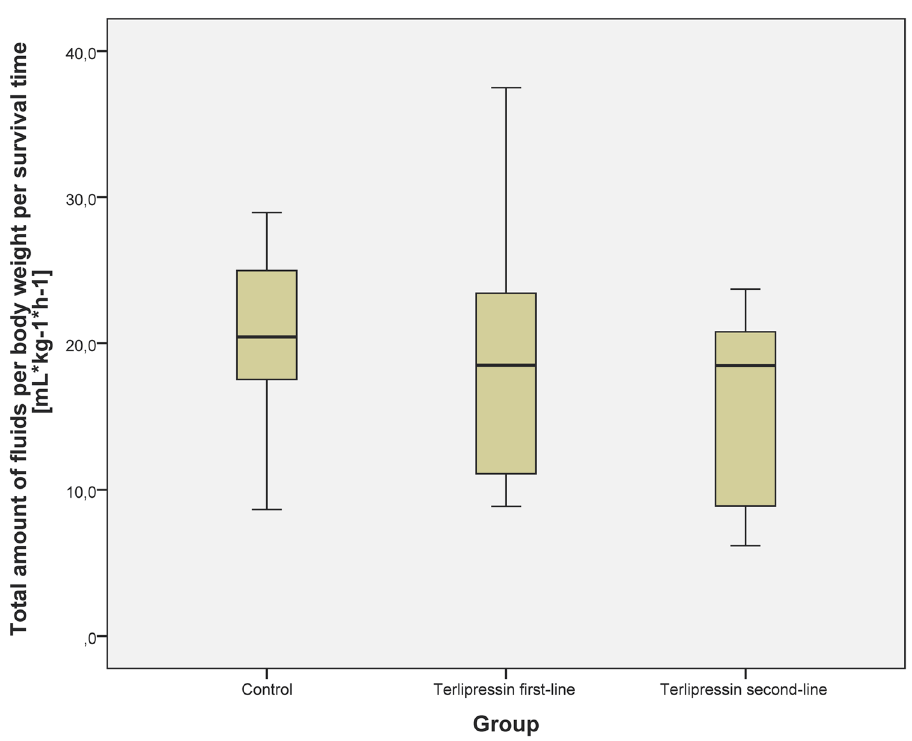
Figure 1. Cumulative fluid amount of the study animals. The figure demonstrates the cumulative fluid amounts of the study animals over the 24-hour interventional period. Data are presented as median [interquartile range].